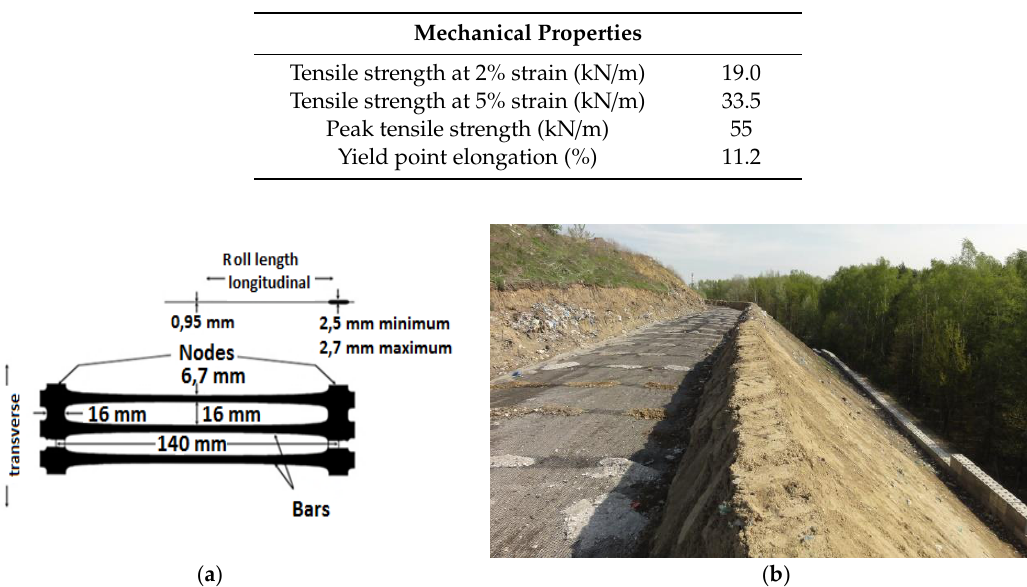
Table 2. Mechanical properties of uniaxial geogrid.